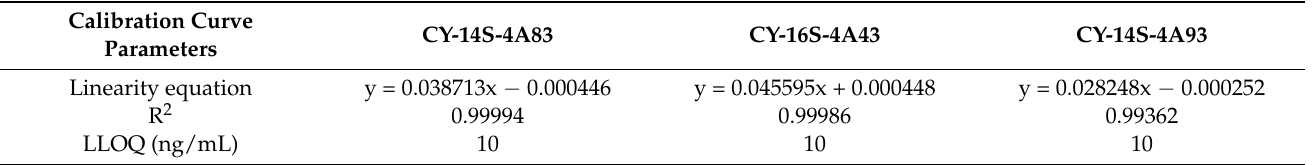
Figure 1. Representative MRM transitions for the chromatograms of ( A ) CY-14S-4A93, ( B ) CY- 16S-4A43, ( C ) CY-14S-4A83, and ( D ) IS in rat plasma. Left panel: A, B, and C are LLOQ samples (10 ng/mL) of CY-14S-4A93, CY-16S-4A43, and CY-14S-4A83, respectively and D is a spiked sample (200 ng/mL) of IS. Right panel: blank plasma samples. Table 1. Calibration curve parameters of CY-14S-4A83, CY-16S-4A43, and